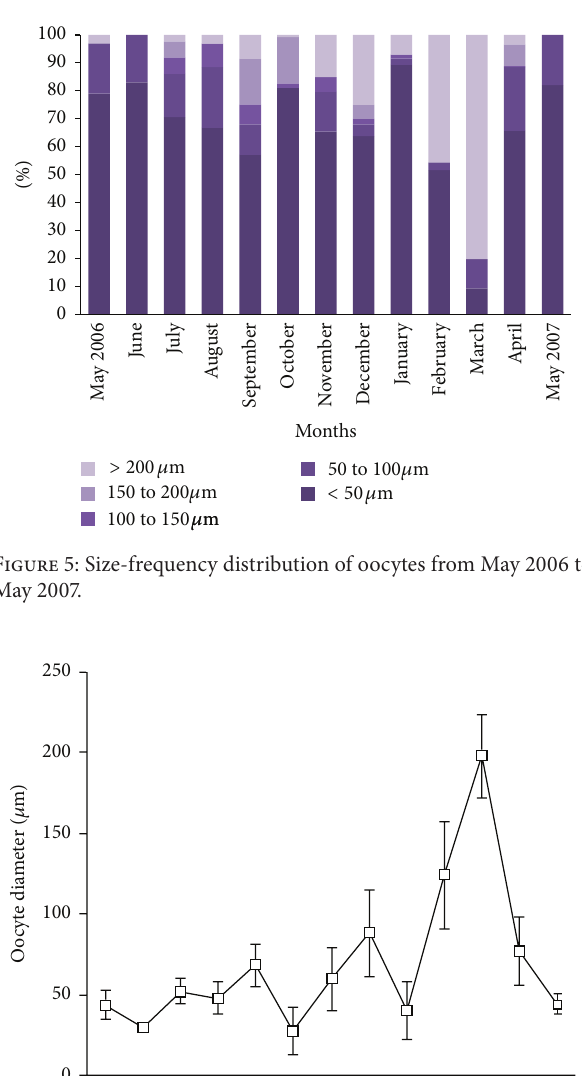
to qualitative differences in blastomere cytoplasm.